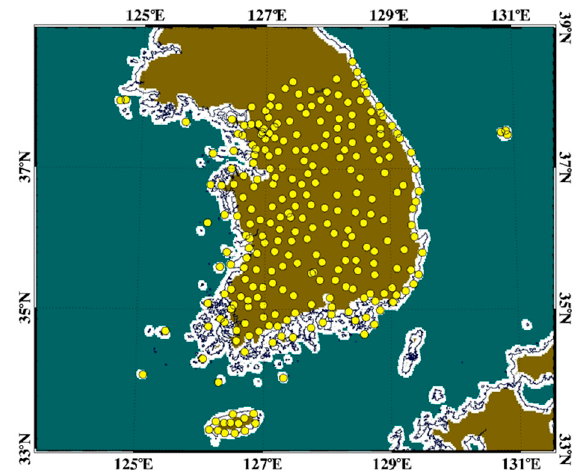
Figure 1. Spatial distribution of the visibility data with land sea mask. Yellow dots represent the stations of the visibility meter data. The white, blue, and brown shaded pixels represent coast, sea, and land, respectively.